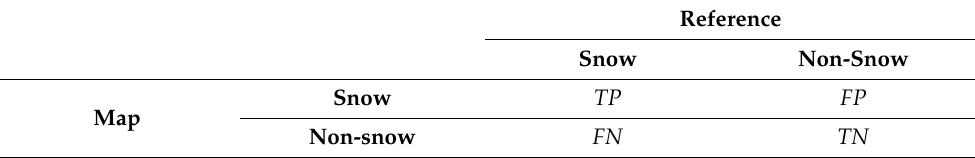
Table 1. The confusion matrix for MODIS snow cover product